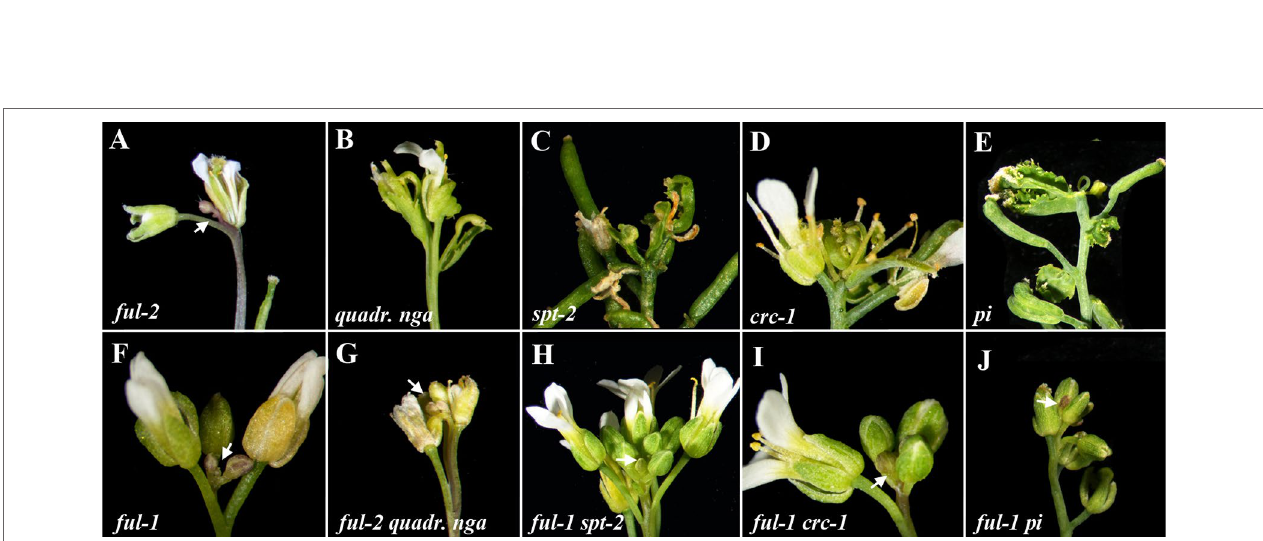
FIgURe 2 | Terminal flower formation is never observed in ful mutants. ful mutants show an extended flowering phase with a morphologically distinct inflorescence meristem always present that remains active (a , F) . Mutants with strongly reduced fertility show inflorescences that terminate with the formation of a terminal flower as shown for the quadruple nga (B) , spt-2 (c) , crc-1 (D) , or pi (e) . When these sterile mutants are combined with ful, the formation of the terminal structure is suppressed and meristems remain active until the death of the plant (g , h , I , J) .